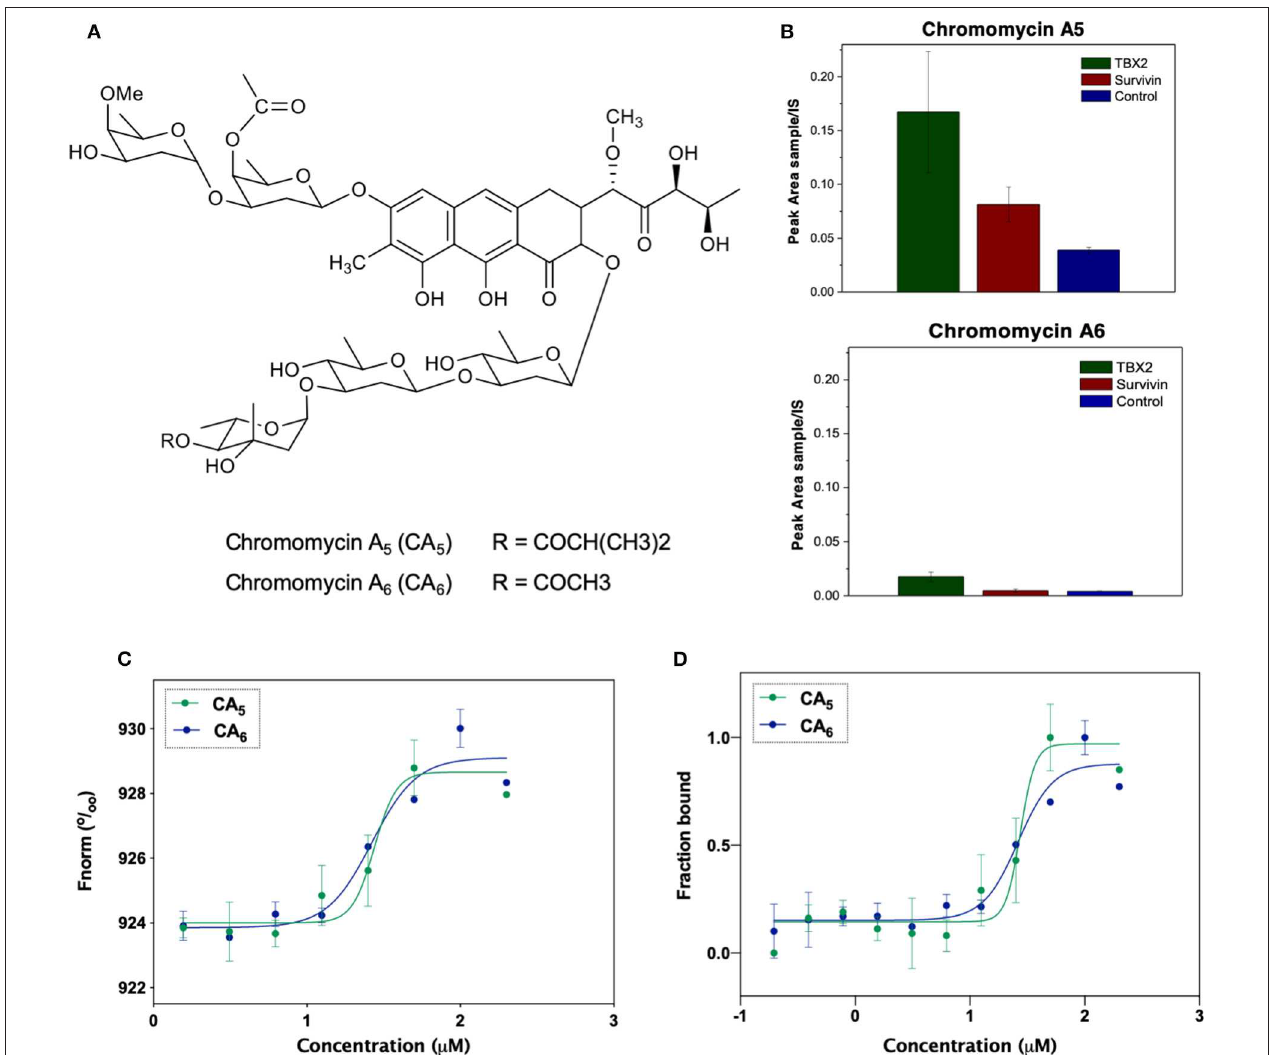
FIGURE 1 | (A) Chemical structures of the compounds used in the present study: chromomycin A 5 and chromomycin A 6 . (B) Relative quantification of compounds chromomycin A 5 and chromomycin A 6 recovered from the bioaffinity chromatography technique using resins functionalized with TBX2 (green) or Survivin (red), or non-functionalized (control, blue) resin. The value of peak areas (triplicate) was used to construct the graphic. (C) Binding affinities of test compounds to TBX2 assessed through microscale thermophoresis. Normalized fluorescence of labeled TBX2 in the presence of serial concentrations of each of the test molecules. Data correspond to the mean values from two independent experiments. (D) Bound fraction of fluorescently labeled TBX2 with serial concentrations of each of the two chromomycins CA 5 and CA 6